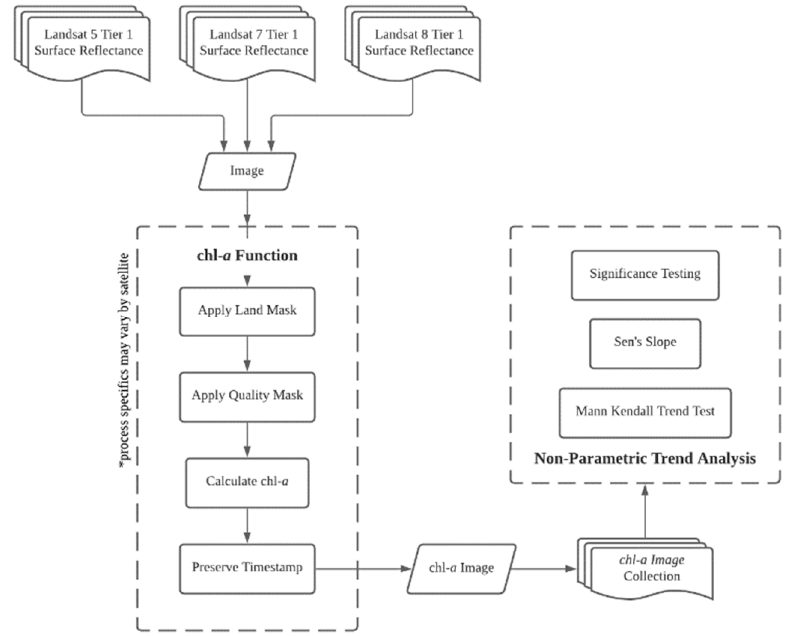
Figure 2. Process flow chart from Cardall et al. [49].